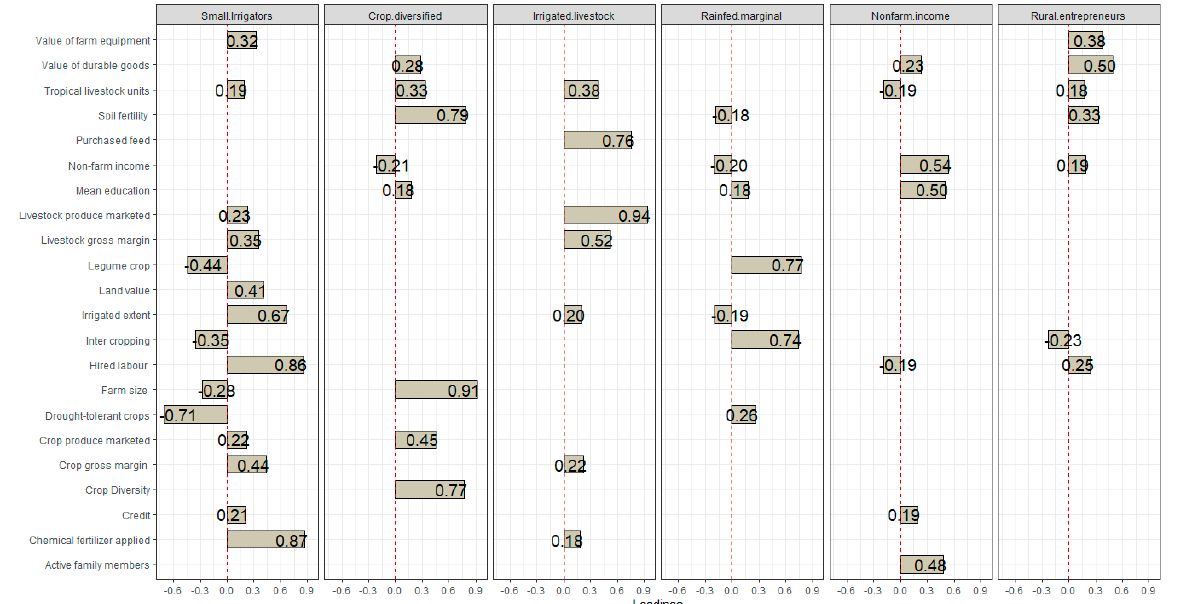
Figure 3. Variable loadings on six livelihood strategies resulted from MFA. Table 4. Household characteristics by livelihood strategy (Mean). levels of fertiliser and labour use, land value, and negative loading on